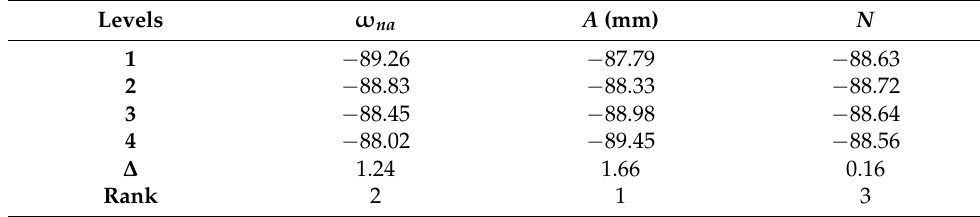
Figure 4. Mean values of the S/N ratios for all the levels of the controlling parameters: optimum levels: A = 4, B = 1, and C = 4. Table 6. The rank values of the controlling parameters for S/N.